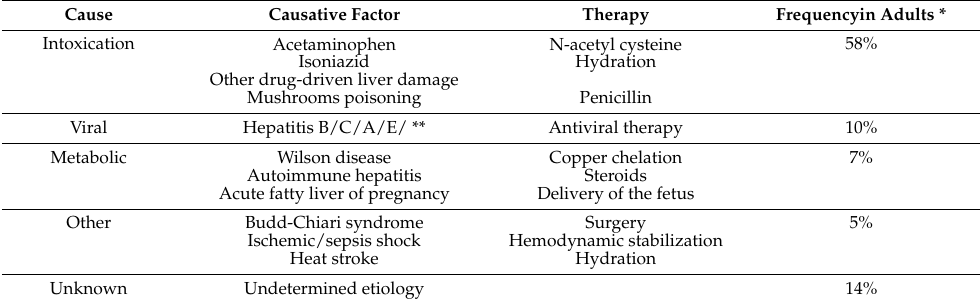
Table 1. Etiology of